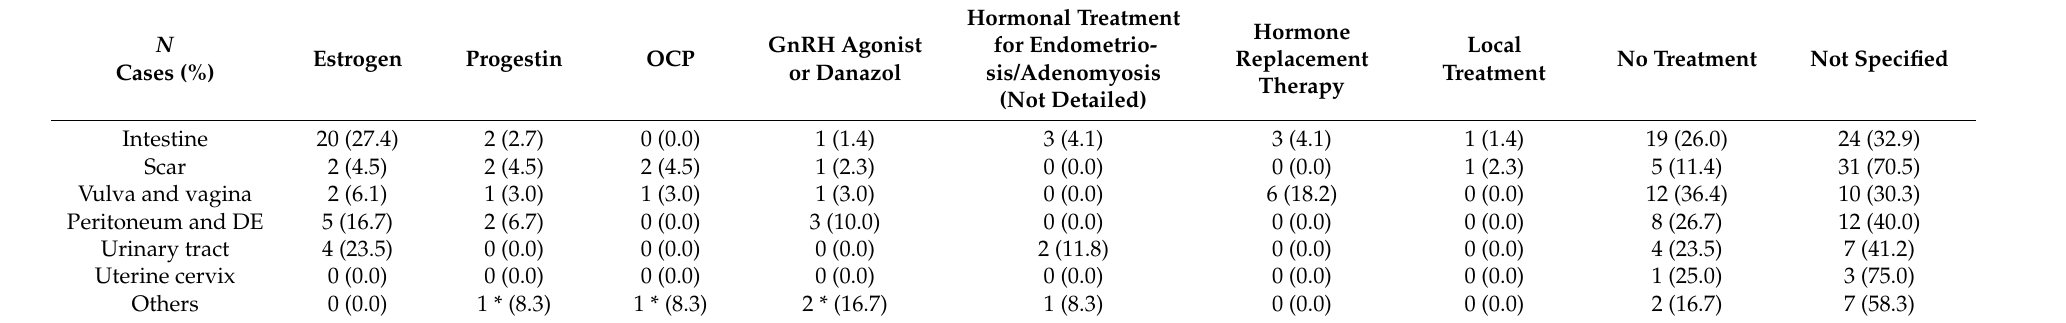
Table 2. Hormonal therapy in each extraovarian site.